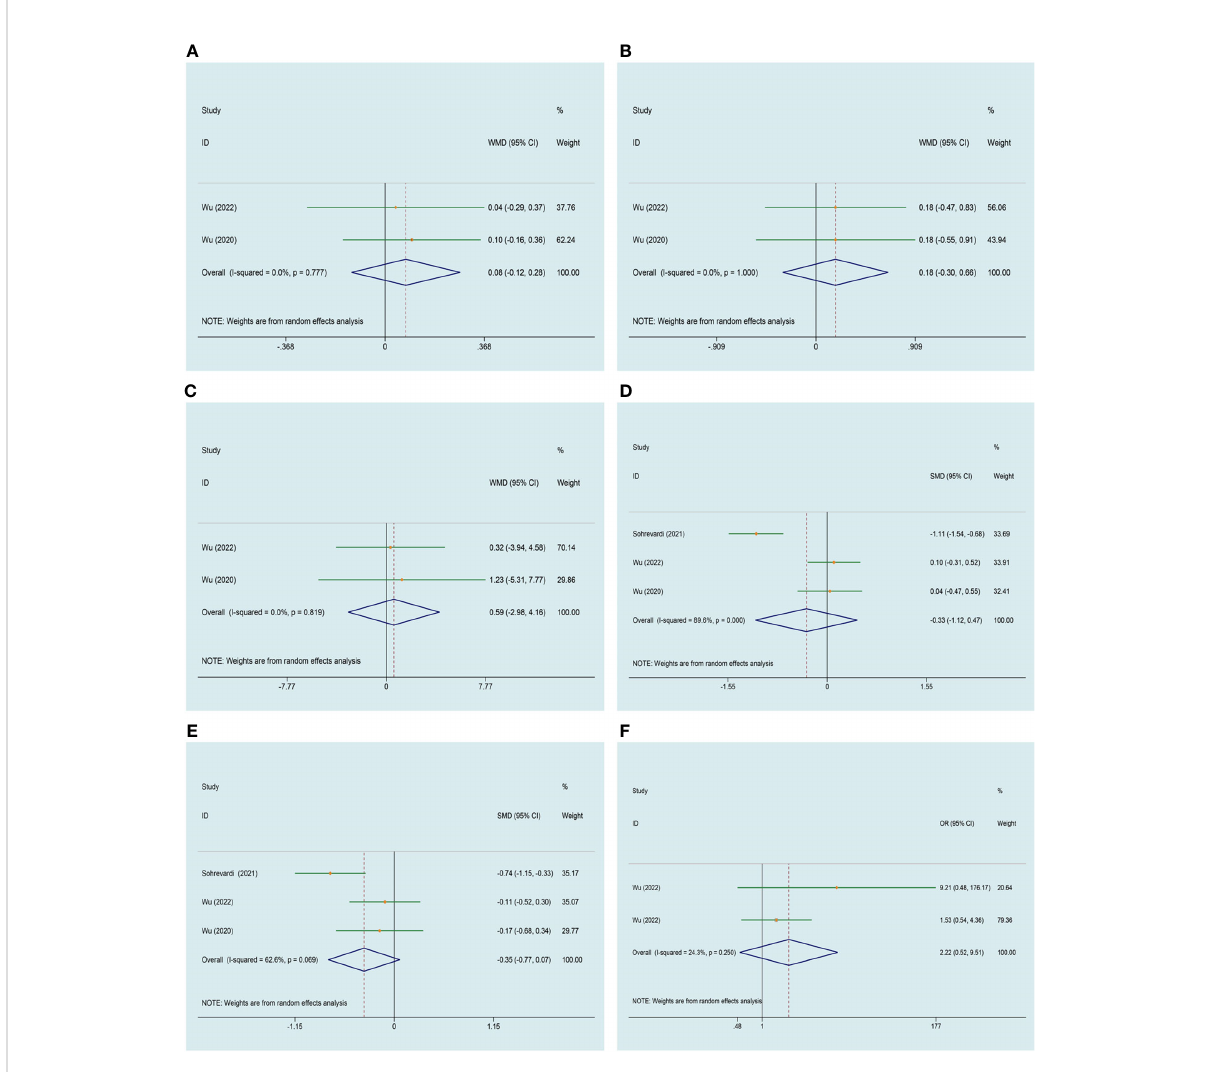
FIGURE 8 Meta-analyses of the effect of curcumin on adverse events. (A) RBC, (B) WBC, (C) Cr, (D) ALT, (E) AST, (F) adverse